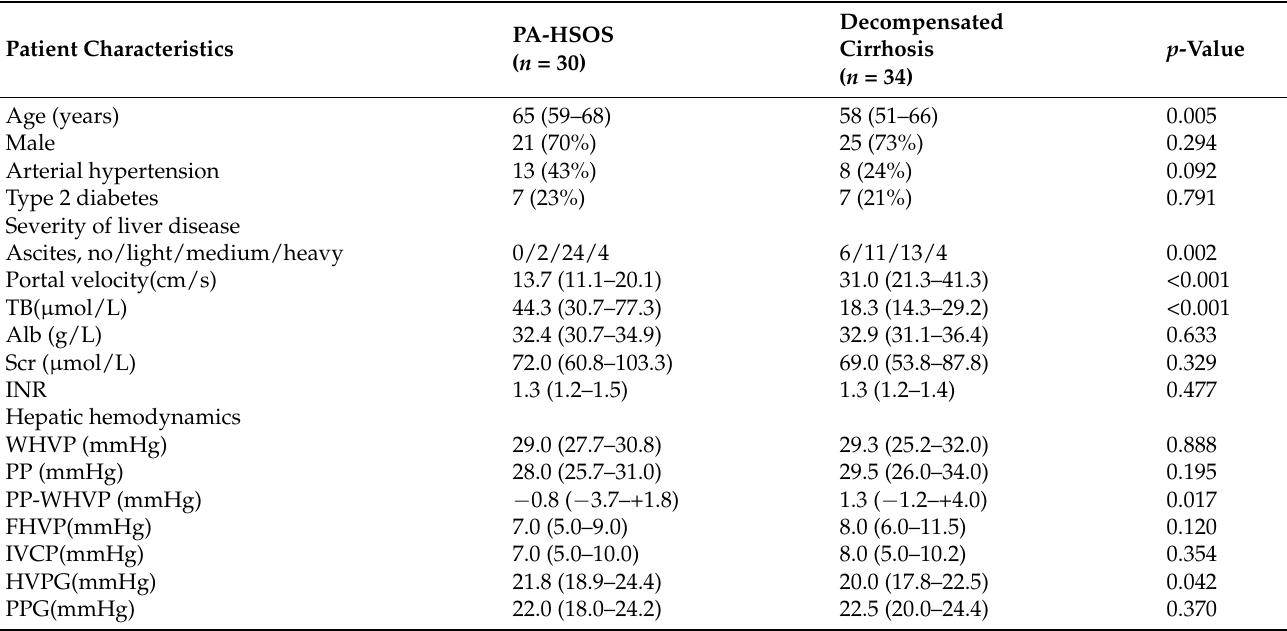
Table 1. Baseline characteristics of the patients.